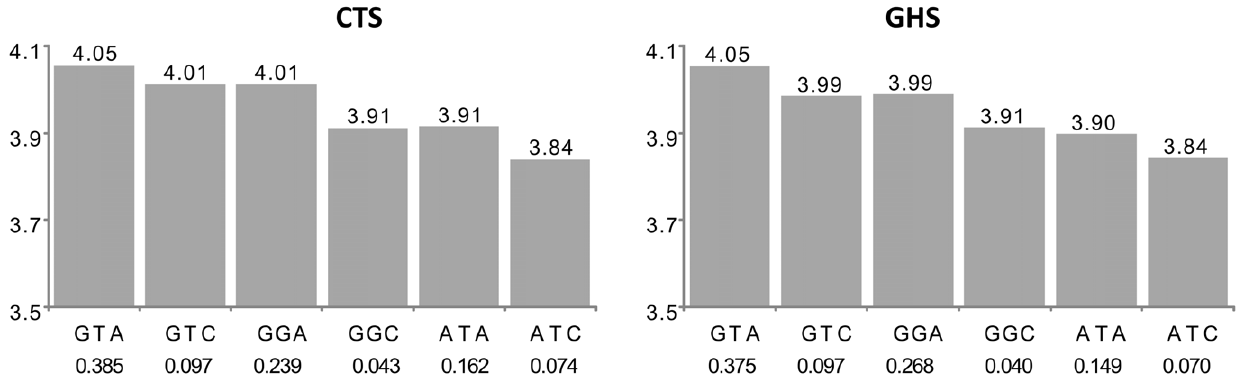
Figure 3. Association between ILMN_1731596 ( AP3S2 ) expression and the main haplotypes derived from rs7173483, rs3803536, and rs1269077. See the first paragraph of legend in Figure 2 for explanations. In CTS, the rs7173483, rs3803536 and rs1269077 were substituted by their corresponding proxies, rs4932145 (r 2 =1), rs10520684 (r 2 =0.92) and rs1256854 (r 2 =0.95), respectively. After imputation, the best cis eSNP in GHS was rs12148357 which was not among the associated htSNPs. Its minor allele was associated with decreased AP3S2 expression ( b = 2 0.146; p=1.59 10 2 54 ). However, in the conditional model adjusting for haplotype effects, its effect was no longer significant ( b = 2 0.022, p=0.420) suggesting that it was due to LD with haplotypes. The haplotypic association was compatible with the additive effects of three SNPs. The rs7173483- A allele was associated with decreased AP3S2 expression ( b = 2 0.147, p=2.80 10 2 18 and b = 2 0.1500; p=9.50 10 2 11 in CTS and GHS, respectively), as were the rs3803536-G allele ( b = 2 0.052, p=5.03 10 2 4 and b = 2 0.065, p=1.75 10 2 6 , resp.) and the rs1269077-C allele ( b = 2 0.067, p=2.93 10 2 7 and b = 2 0.066, p=9.49 10 2 17 , resp.).